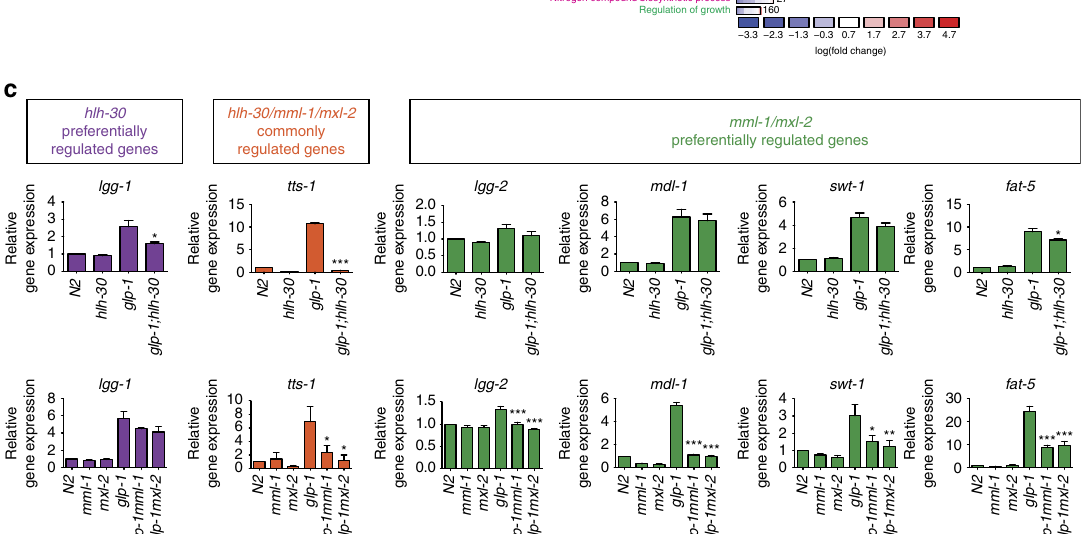
Figure 6 | Transcriptome analysis reveals preferentially regulated and commonly regulated genes by MML-1/MXL-2 and HLH-30. ( a ) Venn diagrams depict the numbers of DEGs identified through RNA-seq analysis from glp-1mml-1 versus glp-1 , glp-1mxl-2 versus glp-1 and glp-1;hlh-30 versus glp-1 . ( b ) GO enrichment analysis using DAVID. The enrichment (upper x axis), fold change (colour coding) and number of genes are shown (next to each bar). See Supplementary Data 5 for details. ( c ) qRT–PCR analysis confirms hlh-30 preferentially regulated genes ( lgg-1 ), hlh-30/mml-1/mxl-2 commonly regulated genes ( tts-1 ) and mml-1/mxl-2 preferentially regulated genes ( lgg-2 , mdl-1 , swt-1 and fat-5 ). The bar represents mean ± s.e.m. from three biological replicates relative to N2. P -value (* P o 0.05, ** P o 0.01 and *** P o 0.001) was determined by one-way analysis of variance (ANOVA) with Tukey’s test relative to glp-1